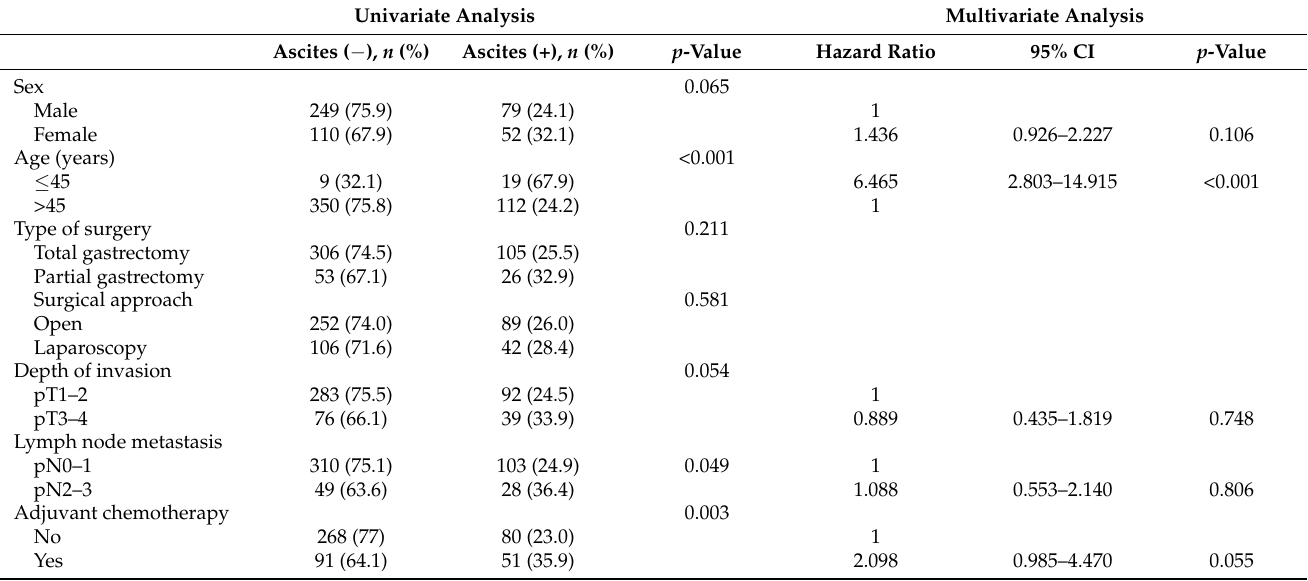
Table 2. Risk factors related to the occurrence of benign ascites in disease-free patients. Univariate Analysis Multivariate Analysis